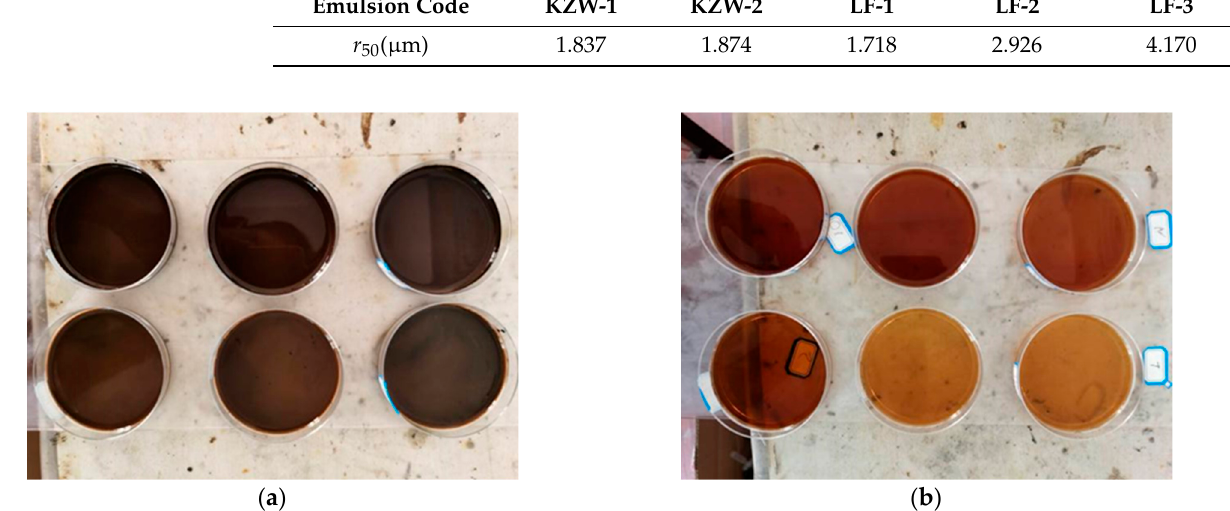
Figure 2. Drying test of asphalt emulsion and emulsifier solution, ( a ) Asphalt emulsion, ( b ) Emulsifier solution.